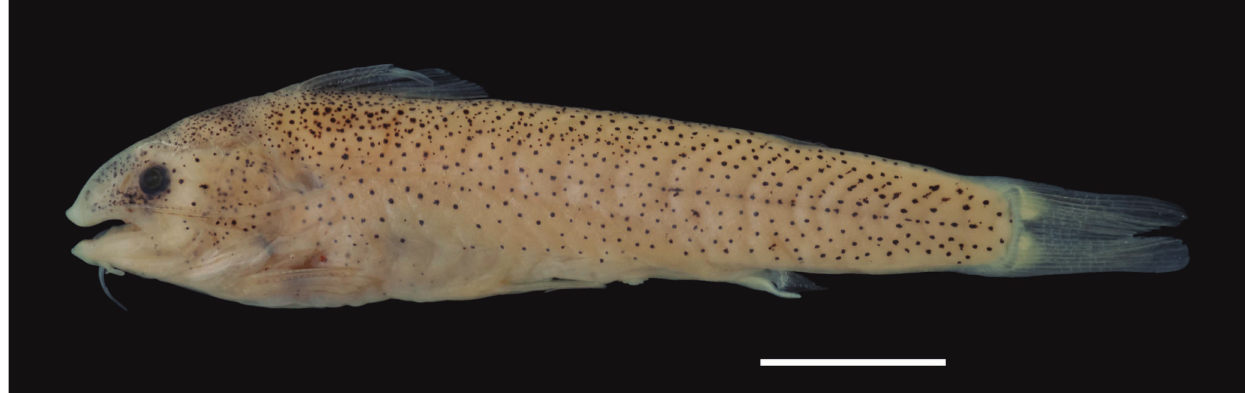
Fig. 1. Gelanoglanis pan , MZUSP 114669, holotype, male, 24.7 mm SL; Brazil, Mato Grosso State, Itaúba, rio Teles Pires, tributary to upper rio Tapajós basin; lateral views. Scale bar = 0.5